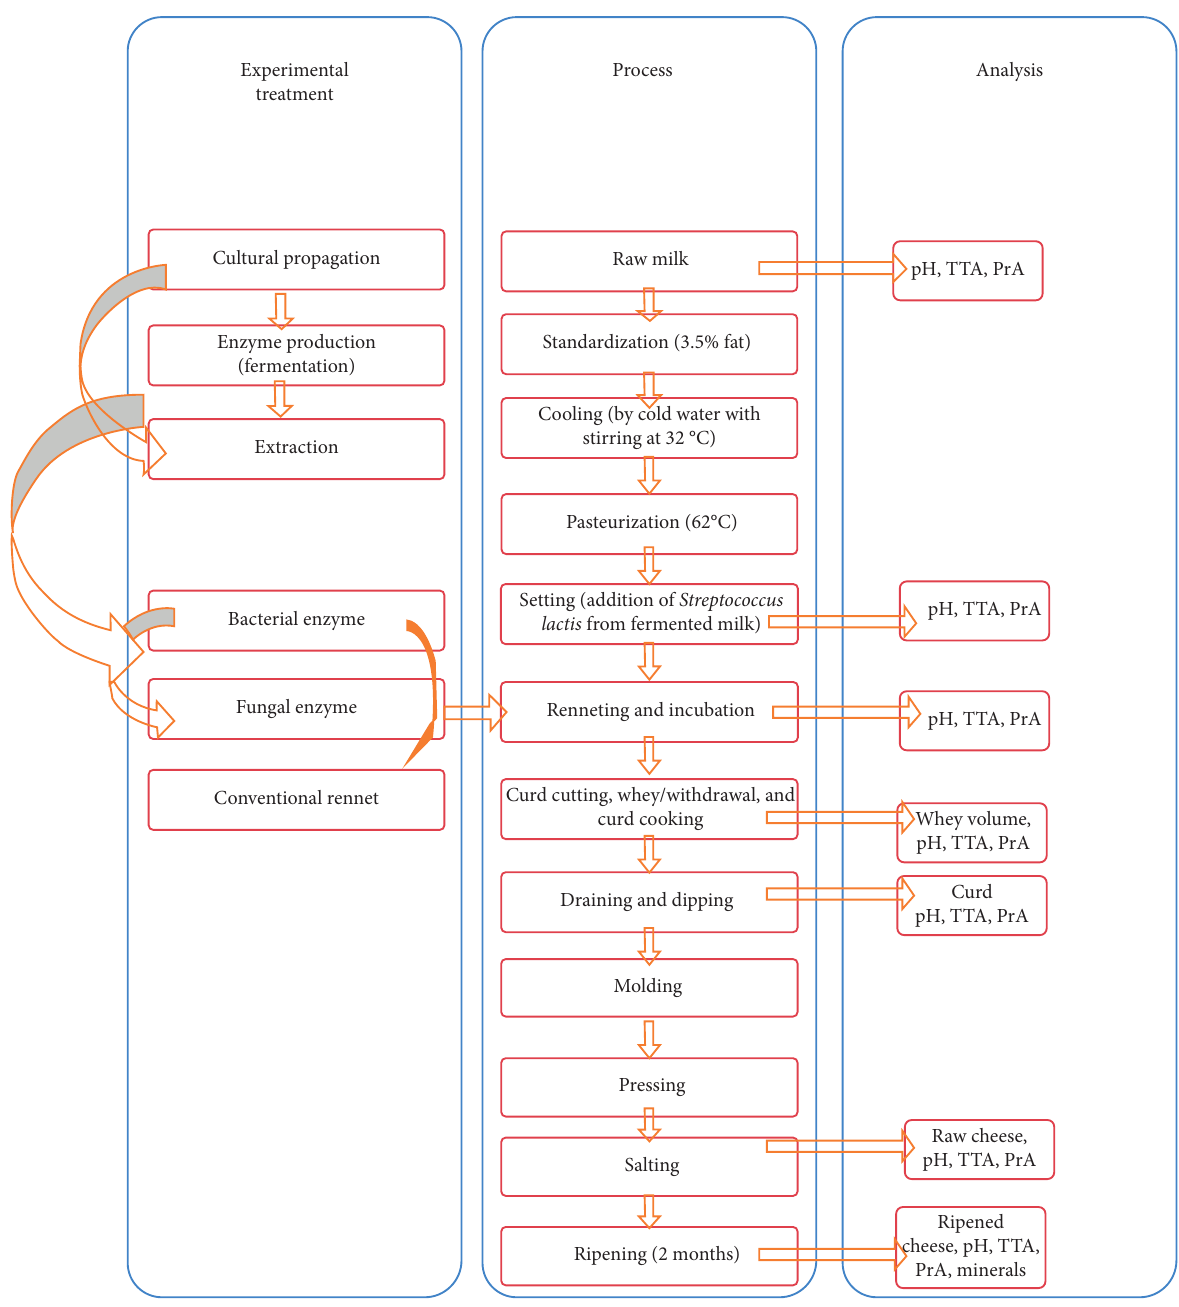
Figure 1: Production and analysis design for Danbo